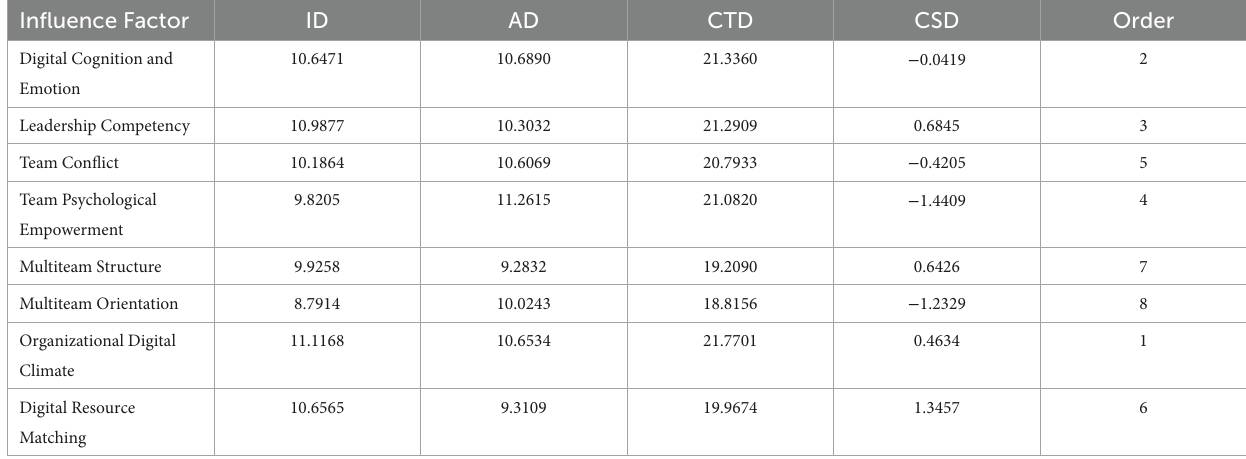
TABLE 4 The results of each degree in the transition